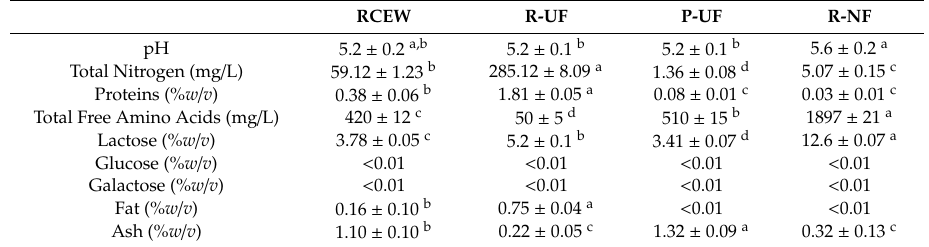
Table 1. Proximal composition of RCEW, and R-UF, P-UF, and R-NF fractions. Protein content is calculated as Total Nitrogen ×